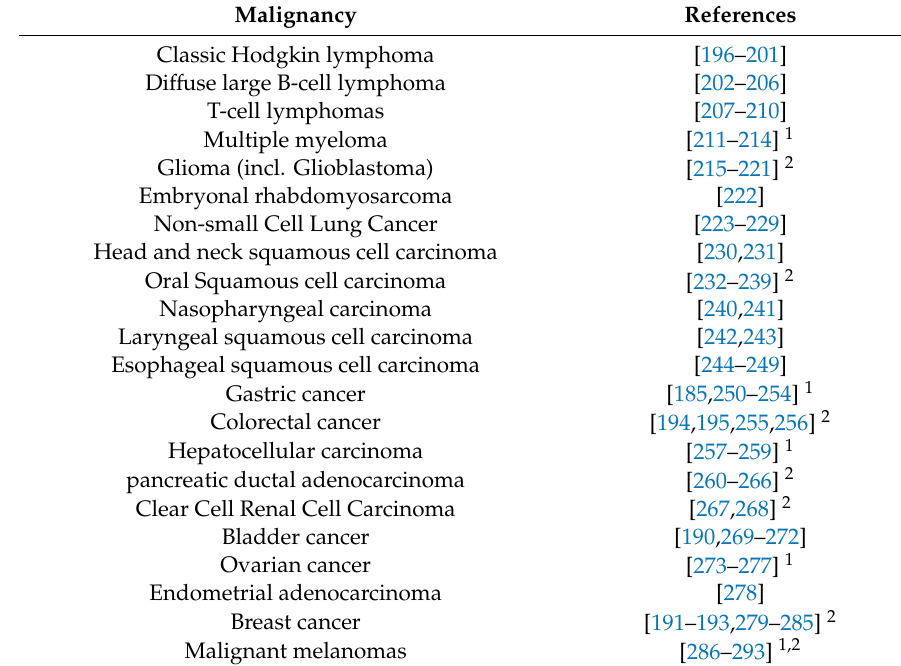
Table 2. Malignant diseases with proven correlation between CD163 + tumor-associated macrophages and reduced